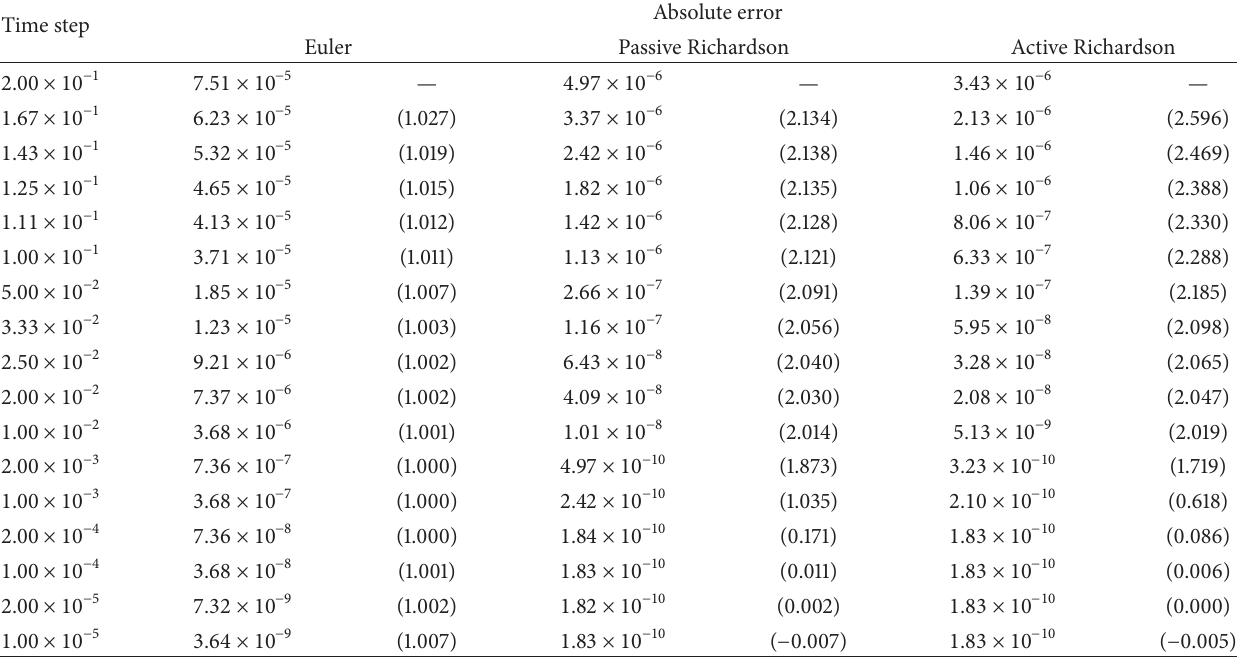
Table 4: Absolute error of the diffusion problem with quadratic reaction term without and with passive/active Richardson extrapolation (with the estimated convergence order in